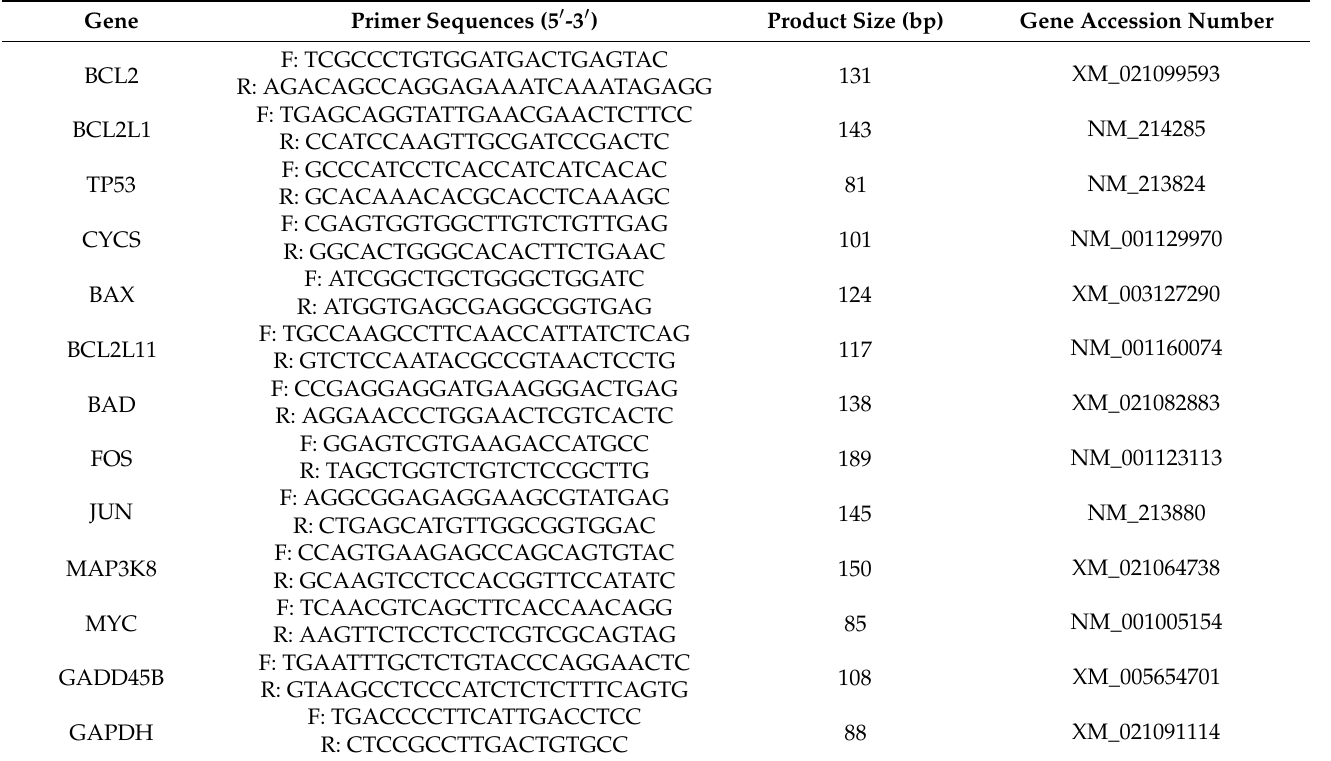
Table 2. Information of primers used for